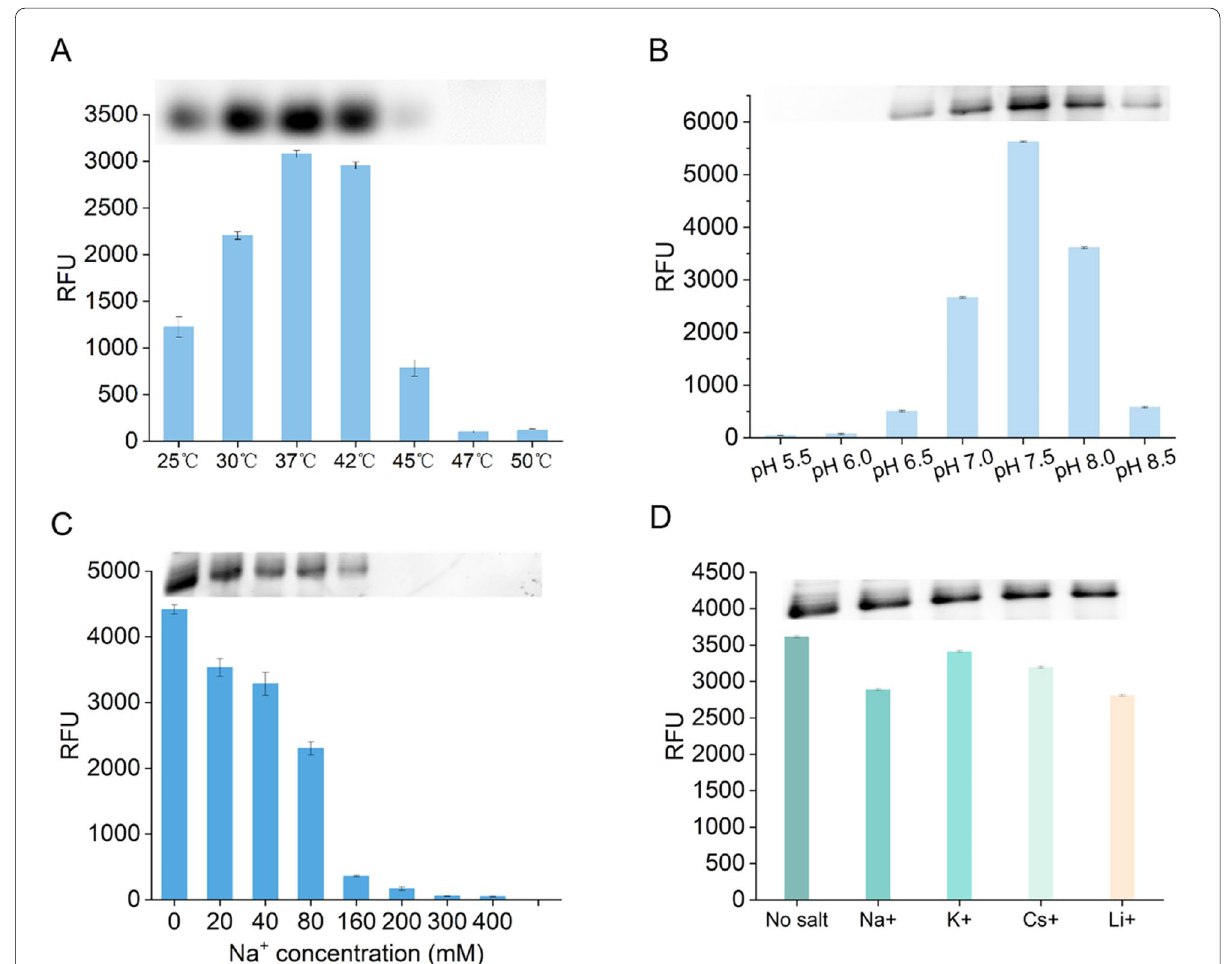
Fig. 4 Effect of temperature, pH, and monovalent ions on the STAR system. A Relative fluorescence unit at a range of temperatures, the inset shows the results of denaturing polyacrylamide gel electrophoresis analysis of the 120‑min transcription products. B Relative fluorescence unit for a range of pH values. C Relative fluorescence unit for a range of NaCl concentrations. D Relative fluorescence unit at 20 mM of different kinds of monovalent ions. Error bars represent the standard deviation of the triplicate